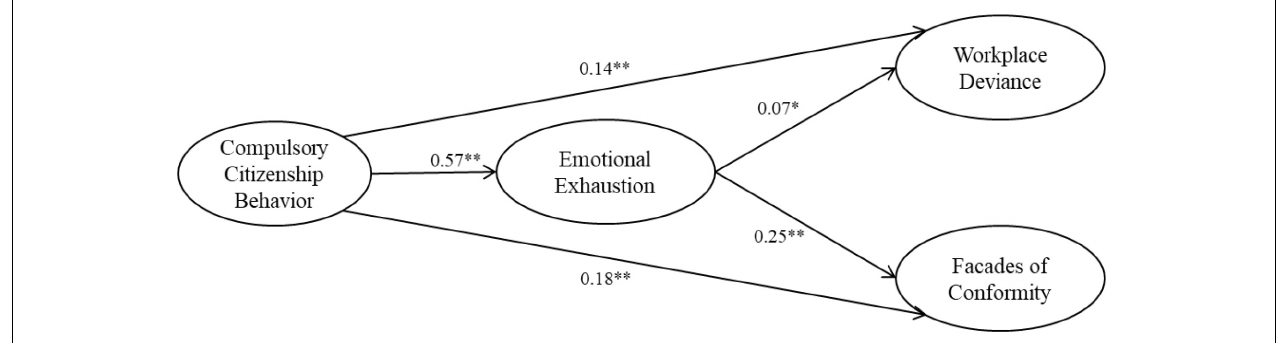
FIGURE 1 | Summary of results. Results are obtained from the structural equation modeling (SEM). ∗ p < 0.05; ∗∗ p <